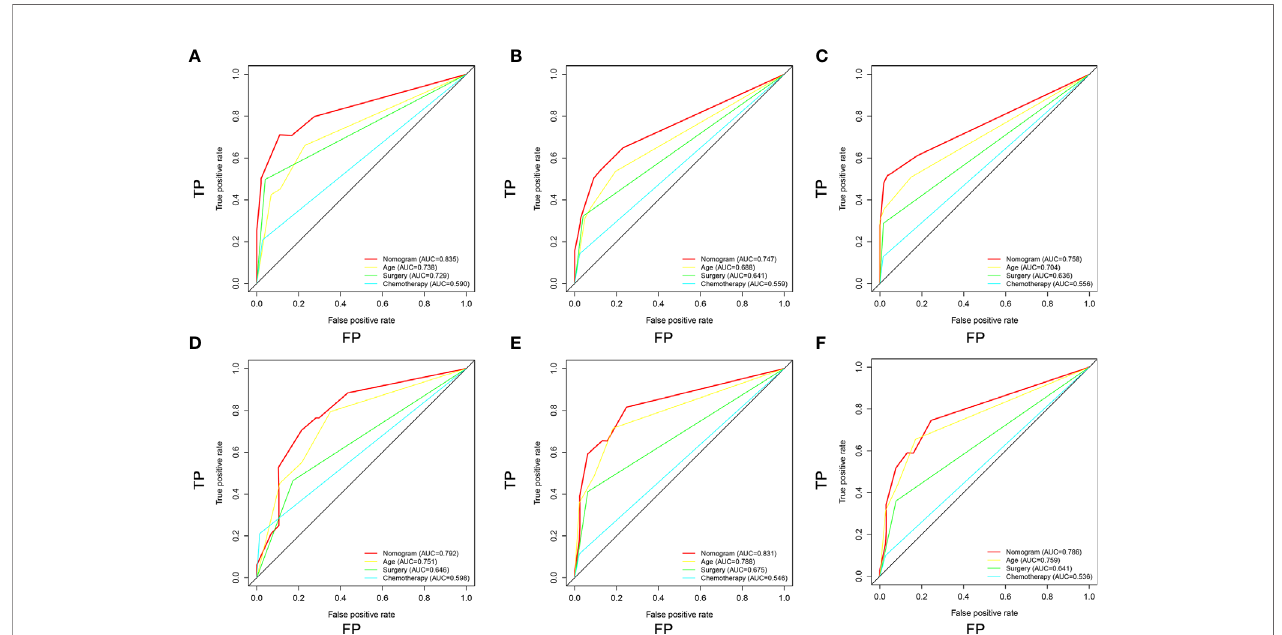
FIGURE 7 | Comparison of area under the receiver operating characteristic curves between nomogram and all independent factors, including Age, Surgery, and Chemotherapy for the 12 (A, D) , 24 (B, E) , and 36 (C, F) months in the training set and validation set.